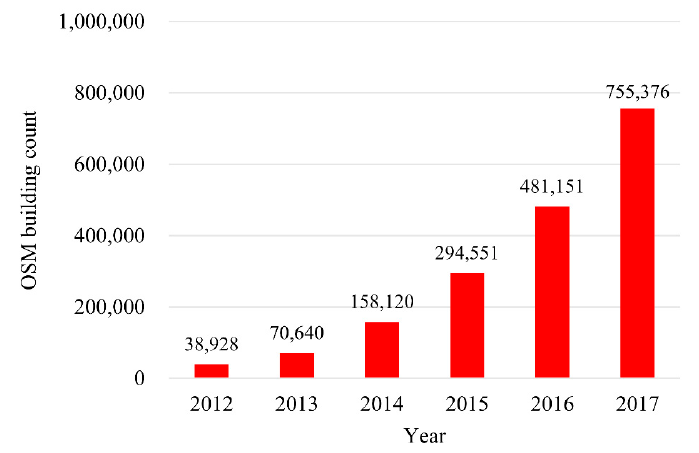
Figure 2. OpenStreetMap (OSM) building counts in China from 2012 to 2017.